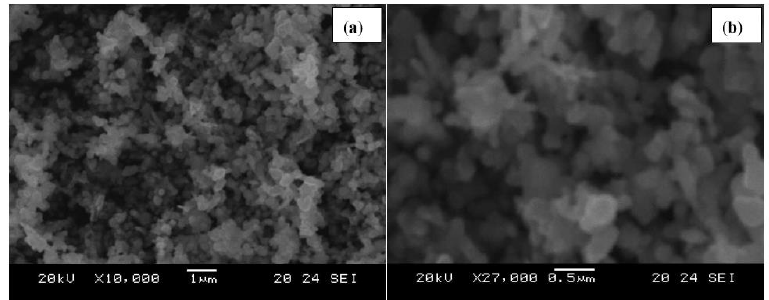
Figure 2. Low (a) and High (b) magnification SEM images of B. ciliate mediated CuO NPs.